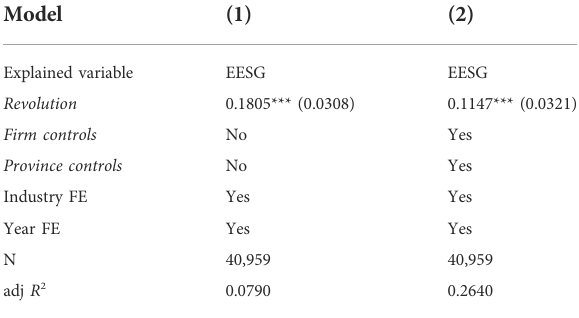
TABLE 4 PBB reform and enterprise